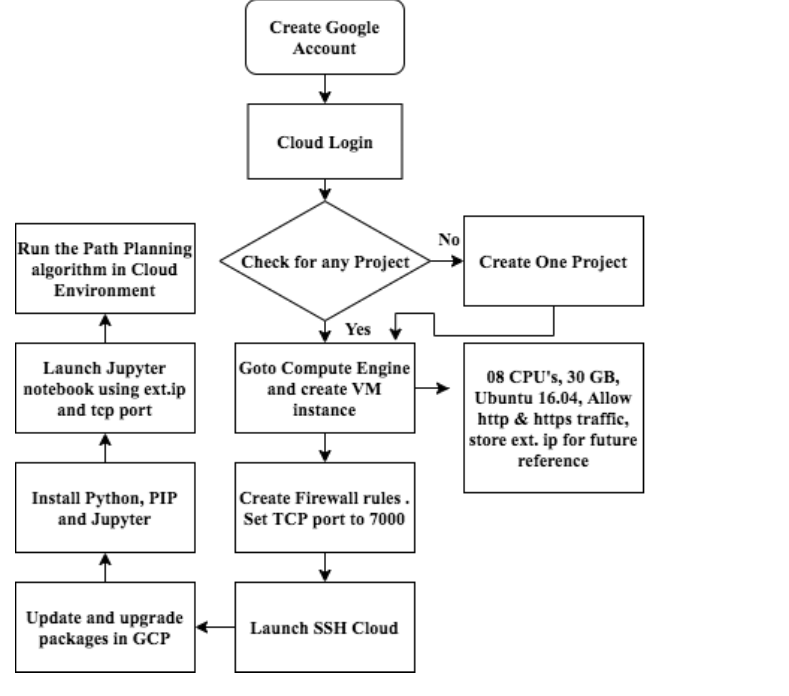
Figure 5. Setting up of cloud environment. Algorithm 1 Networking Module for Cloud